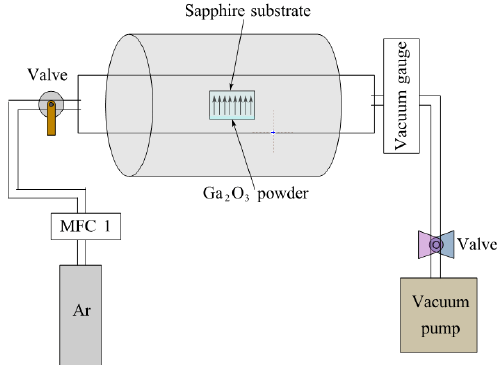
Figure 1. The schematic diagram of the high-temperature tubular furnace.